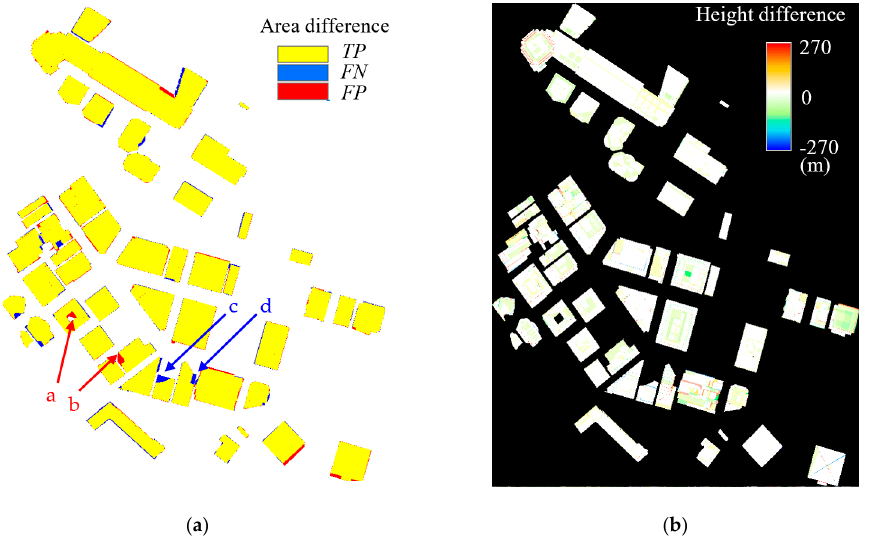
Figure 20. Quantitative evaluation of building surface detection. ( a ) Comparison with the ground- Table 2. D, where TP means true positive detection, FN means false negative detection and FP means false positive detection; ( b ) Comparison with the ground-truth in elevation, where red indicates the generated model is higher than the ground-truth and blue indicates lower.